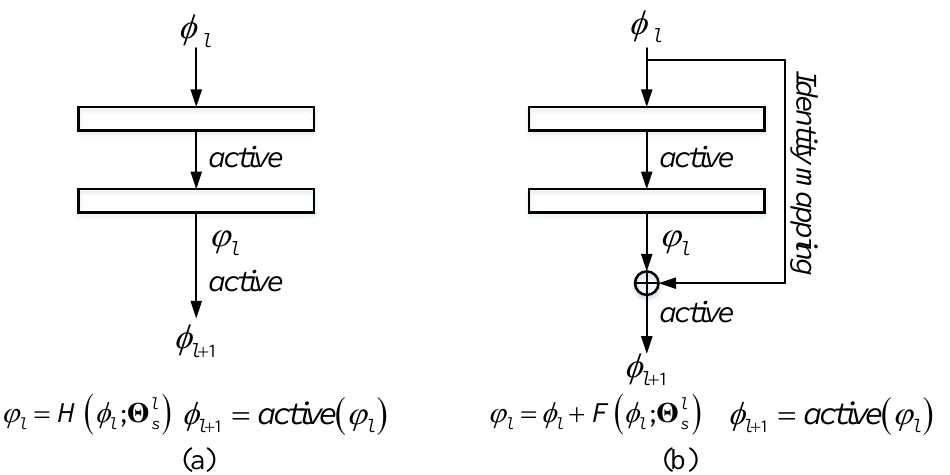
Figure 4. Comparison between the normal fully connection block and the the residual block: ( a ) normal fully connection block; and ( b ) residual